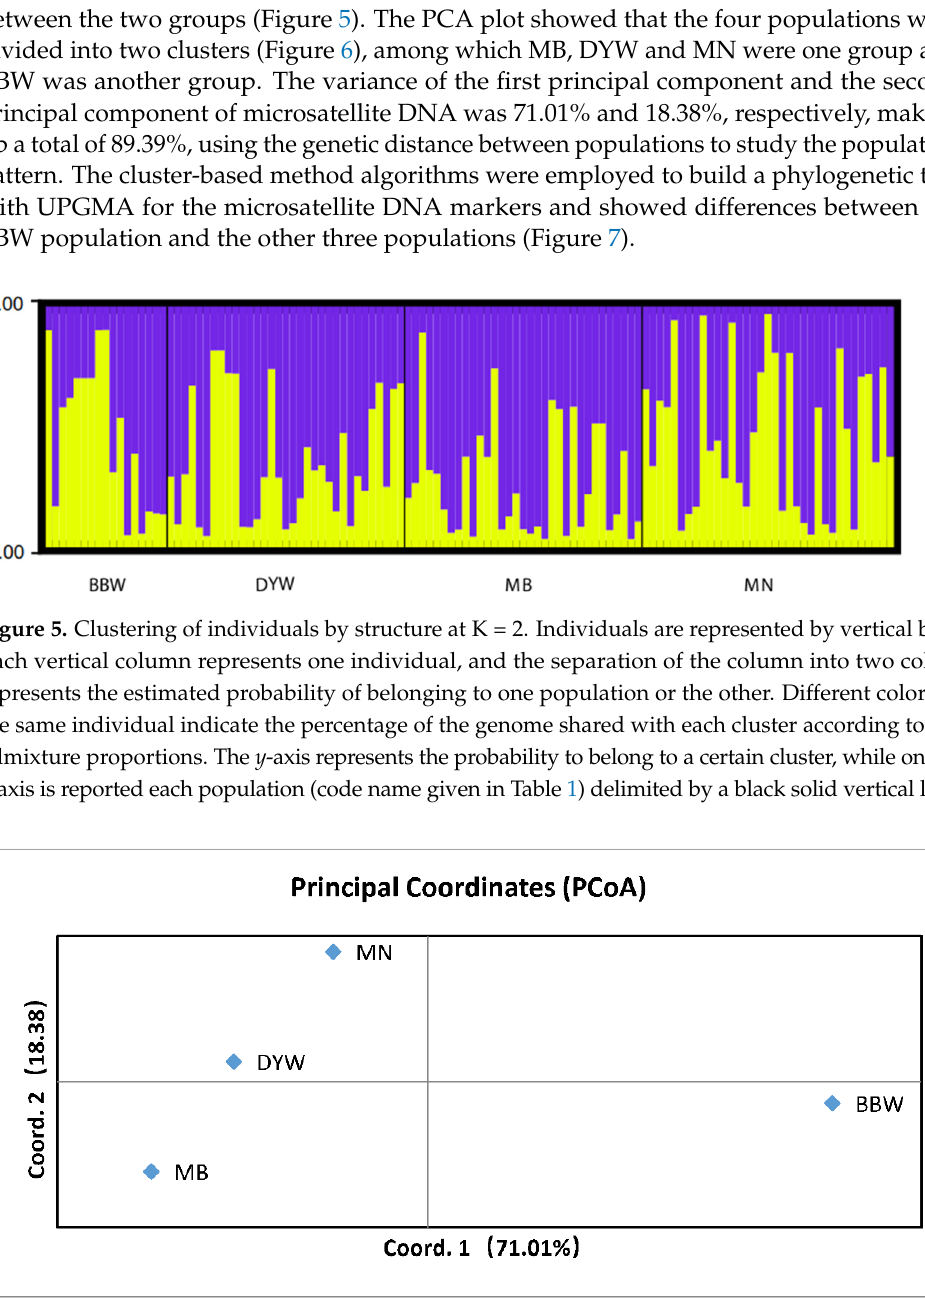
Figure 6. Plot of principal coordinate (PCA) axes for six populations of Epinephelus awoara based on population genetic distance. Percentage values represent variation justified by each axis. MN: Southern Fujian population; MB: Northern Fujian population; DYW: Daya Bay population; BBW: Beibu Gulf population. See Table 1 for the sampling sites/population codes.